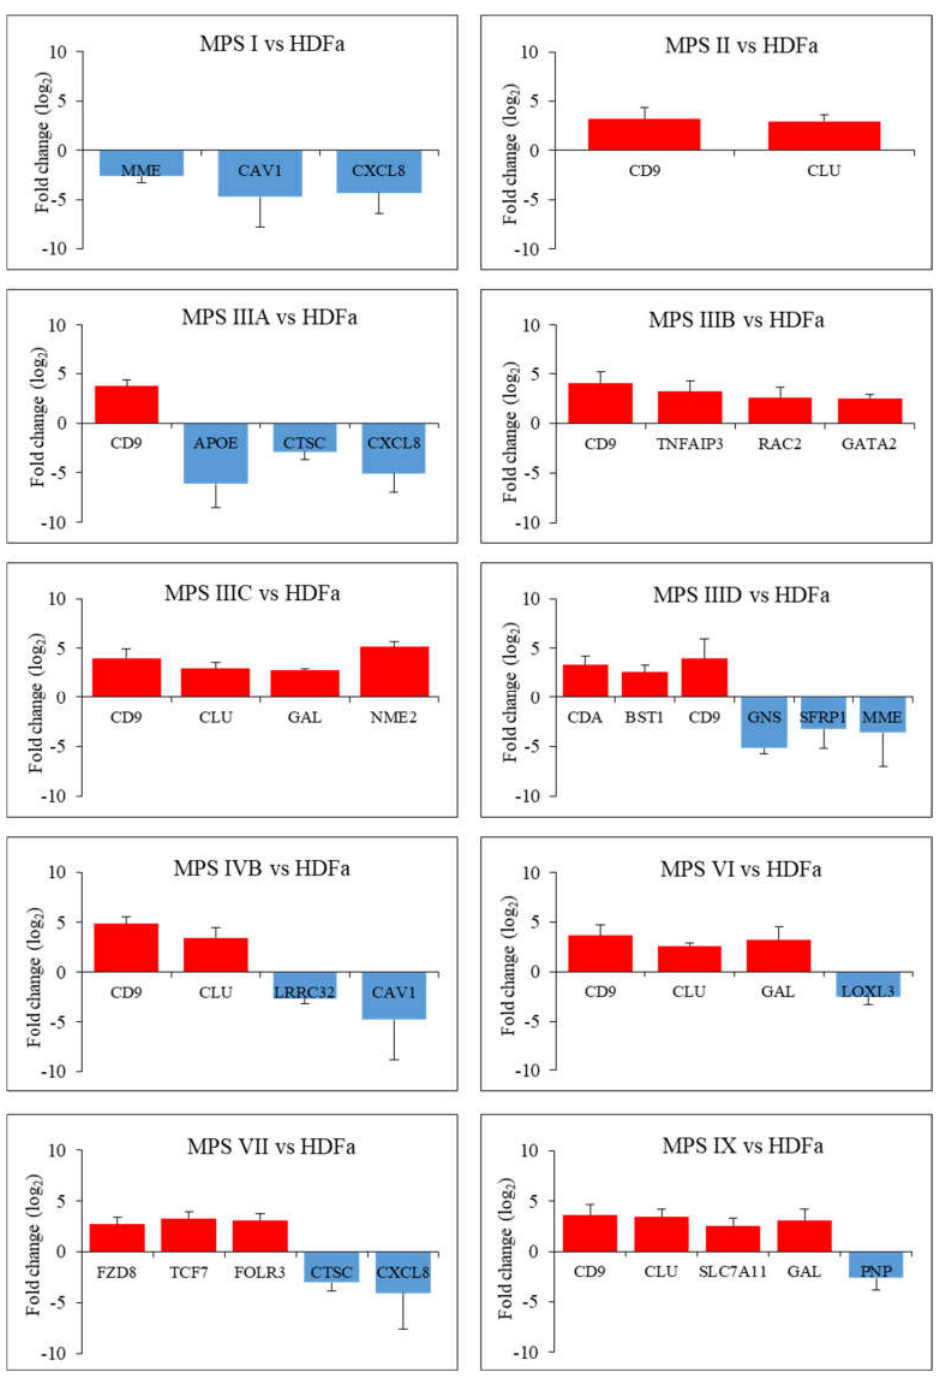
Figure 3. Diagrams presenting genes particularly up- and down-regulated (FDR < 0.1; p < 0.1; log 2 fold change (FC) > 2.5) in each type of MPS compared to HDFa cells taking part in the cell activation process along with an indication of the exact log 2 fold change (FC) value for each gene.